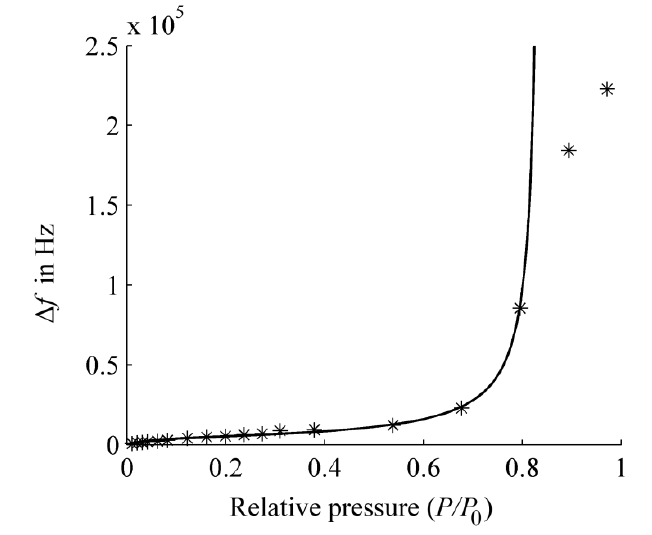
Figure 4. The oscillation frequency shift Δ f versus the relative pressure P / P temperature of 25 °C. Solid line: the calculated curve; stars: the measured